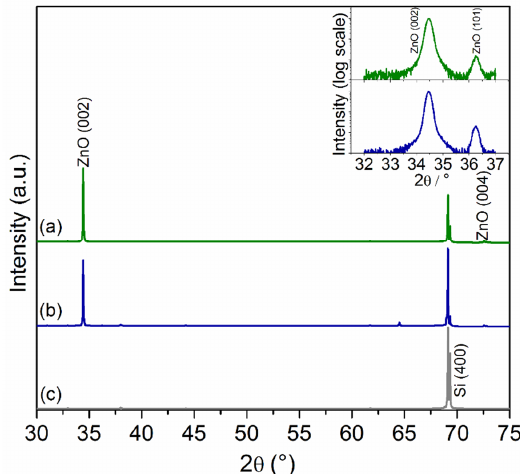
Figure 9. XRD spectra of ZnO nanowhiskers grown in optimized conditions at di ff erent runs ( a ), ( b ) on silicon wafers ( c ). Reflections at 2 θ ≈ 38 ◦ and 64 ◦ arise from the equipment sample holder of aluminum. Inset spectra were obtained via GI-XRD (1° incident angle).